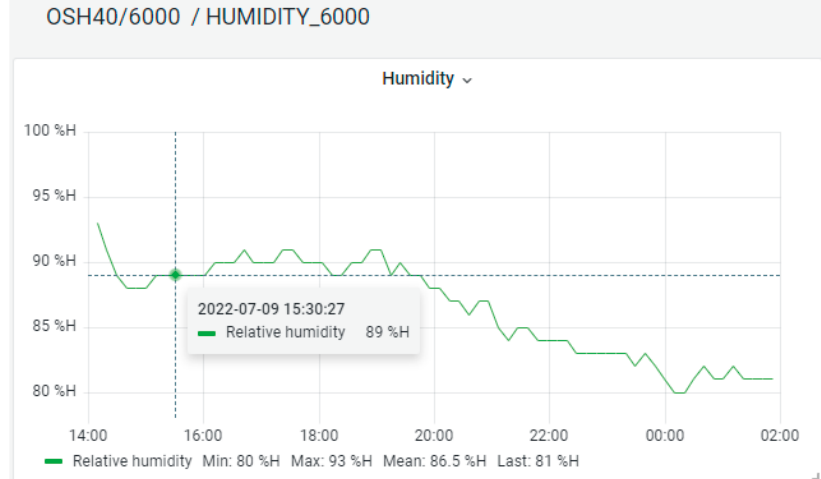
Figure 5. Temperature graph.